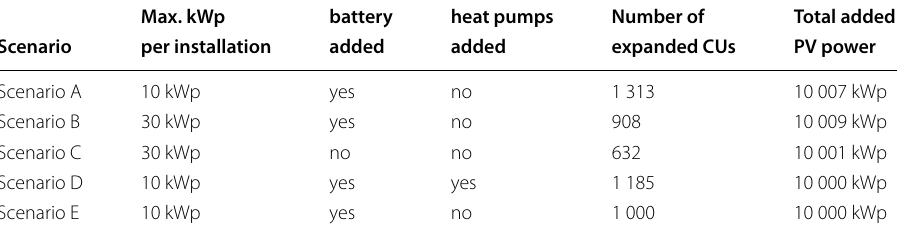
Table 3 Overview of the defined scenarios and some results: the number of Control Units (CUs) with added components and the total sum of added PV